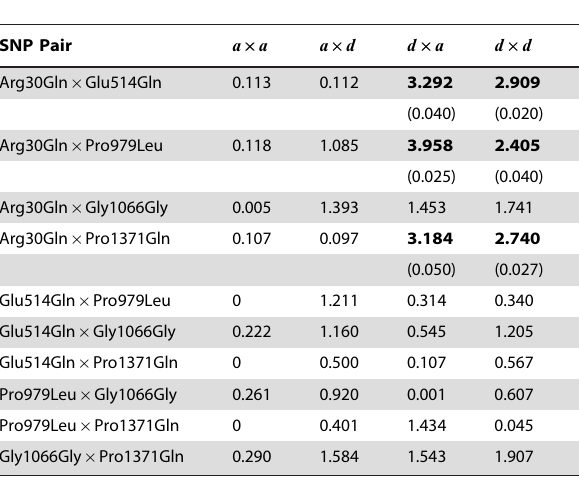
Table 7. The x 2 test statistics calculated to test the two-SNP epistasis between each pair of SNPs genotyped from